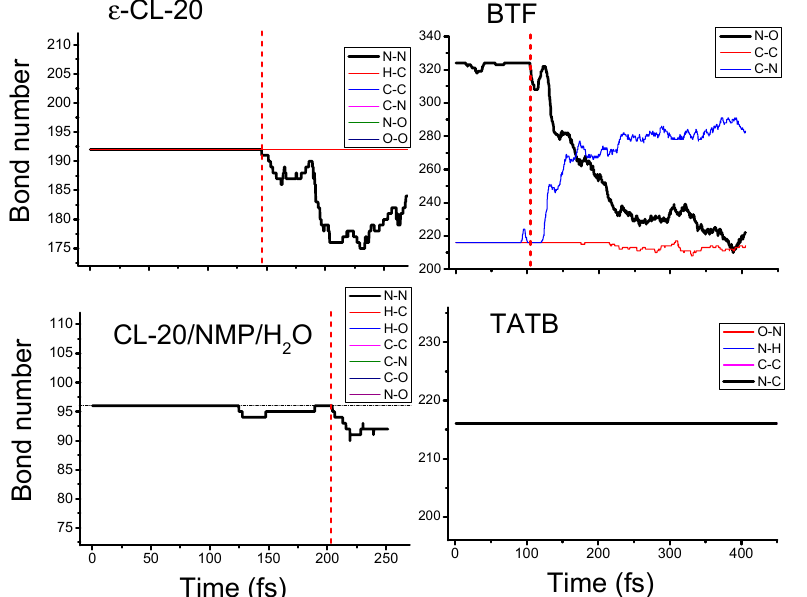
Figure 4. Bond number vs time plots for the shocked ε -CL-20 crystal, BTF crystal, CL-20 / NMP / H 2 O cocrystal and TATB crystal. The chemical bonds counted included N–N, H–C, H–N, H–O, C–C, C–N, C–O, N–O and O–O bonds. The sign of the initiation of the reaction under shock was a continuous reduction in the number of trigger